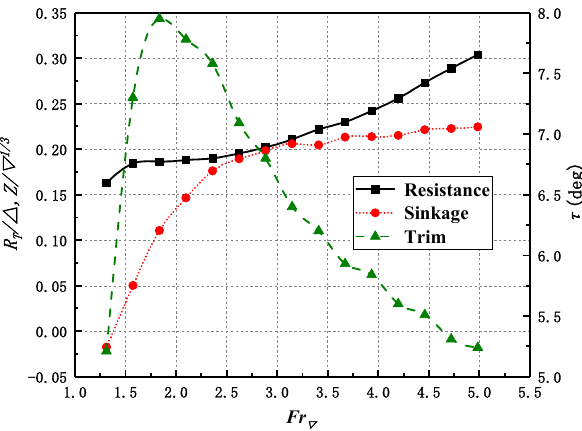
Figure 4. Experimental results at the Fr ∇ ranging from 1.31 to 4.98.